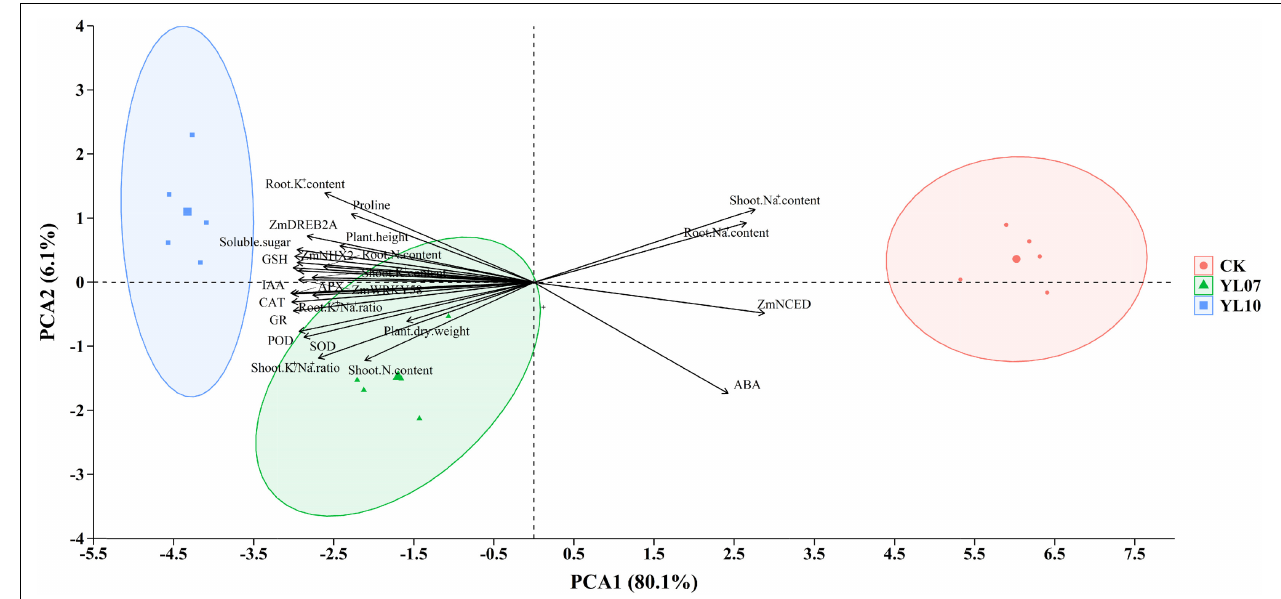
FIGURE 6 | Principal component analysis of all indicators in maize plants under salt